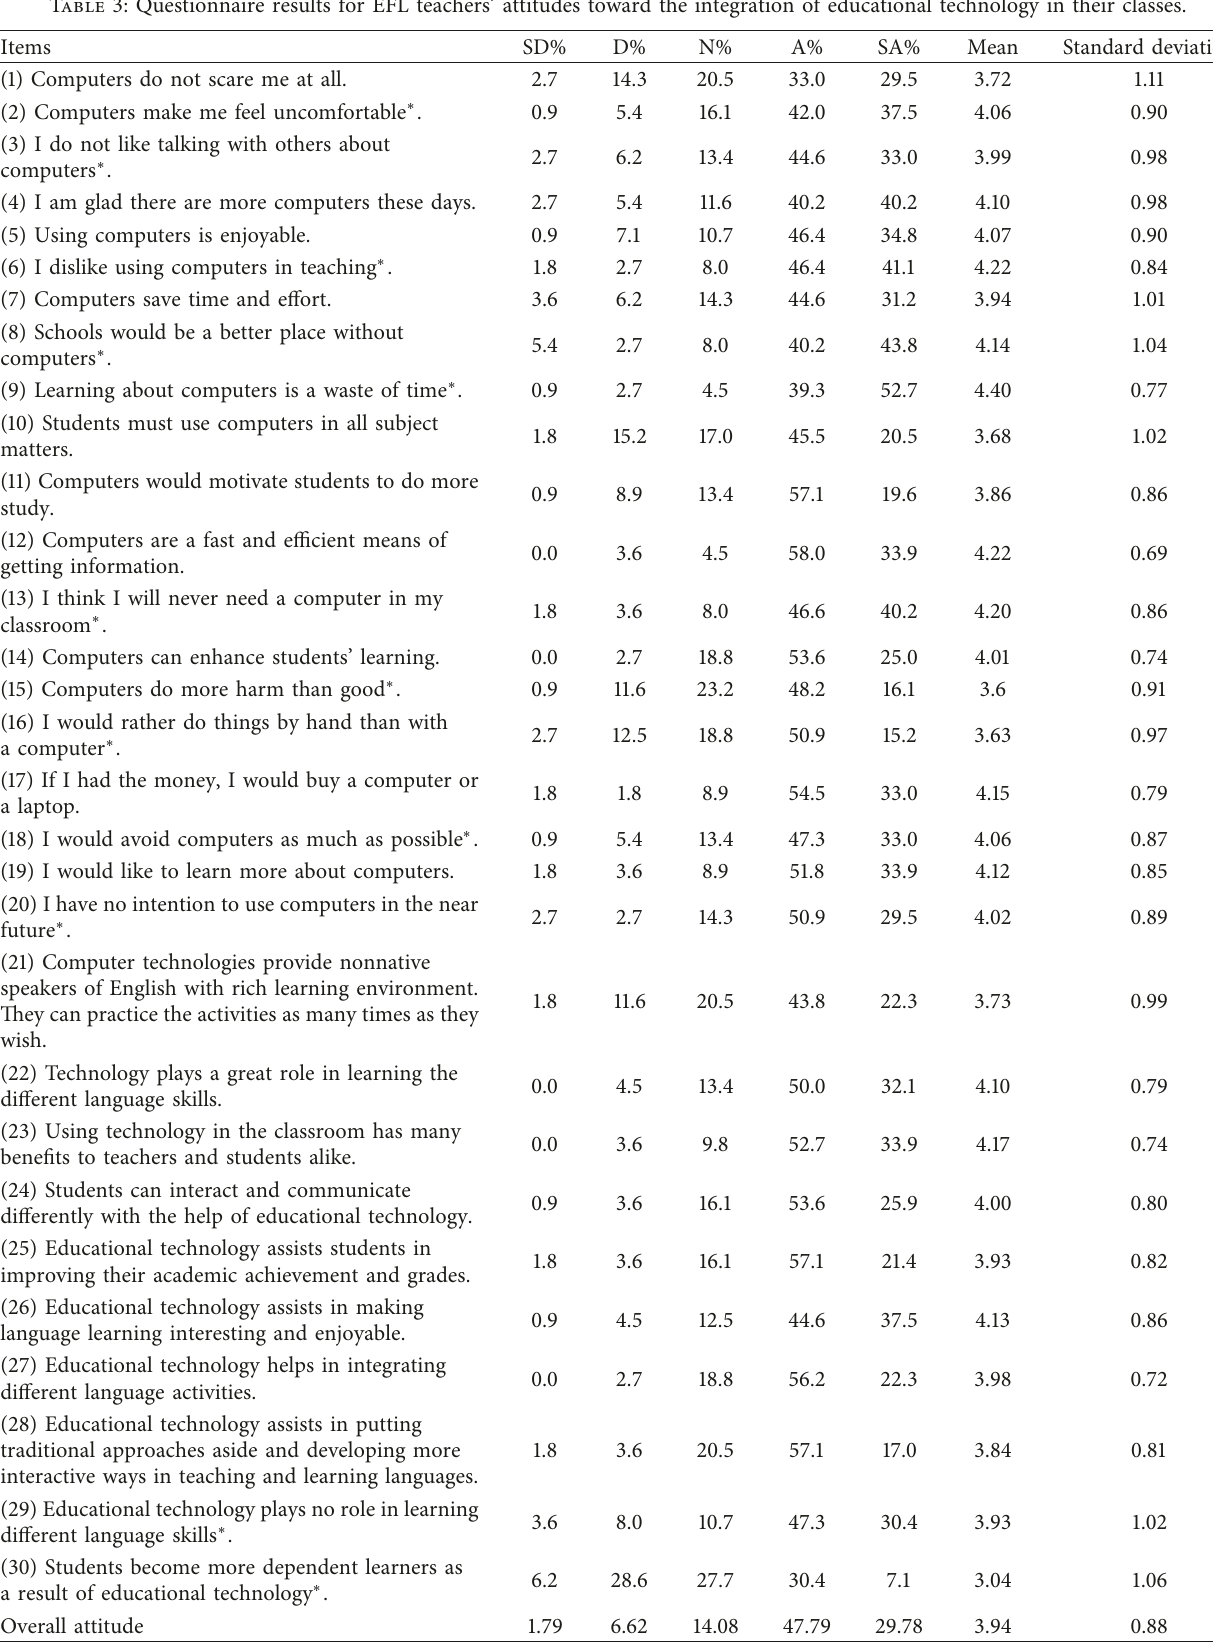
Table 3: Questionnaire results for EFL teachers’ attitudes toward the integration of educational technology in their classes.